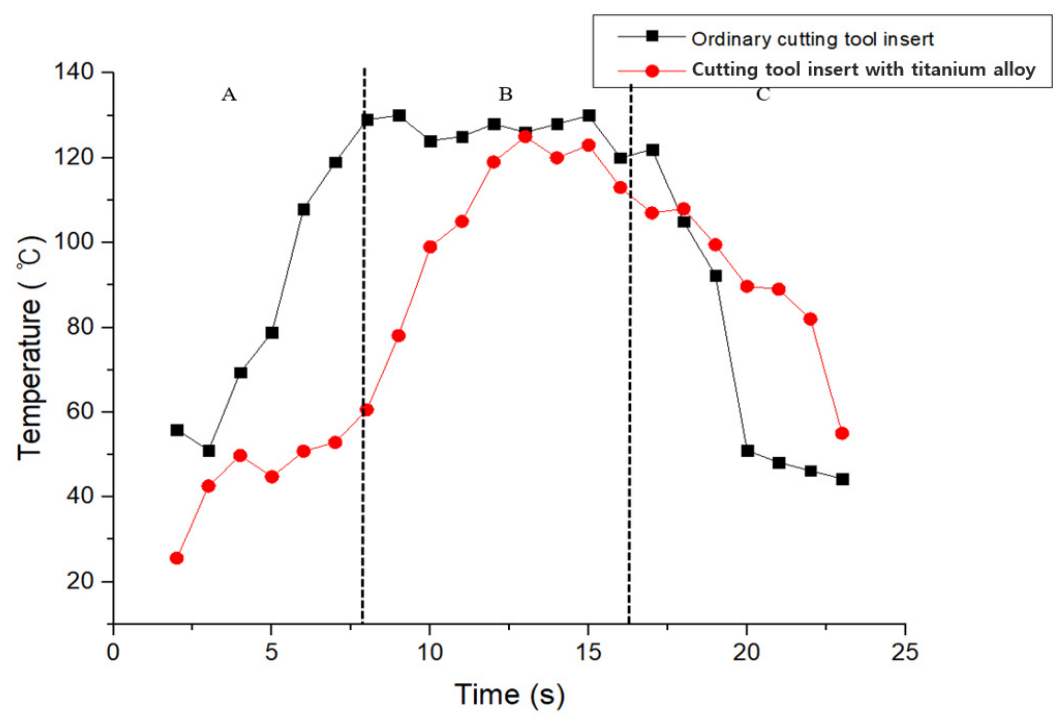
Figure 10. Comparison of the temperature changes between the ordinary cutting tool insert and cutting tool insert deposited by AM of titanium alloy powder.